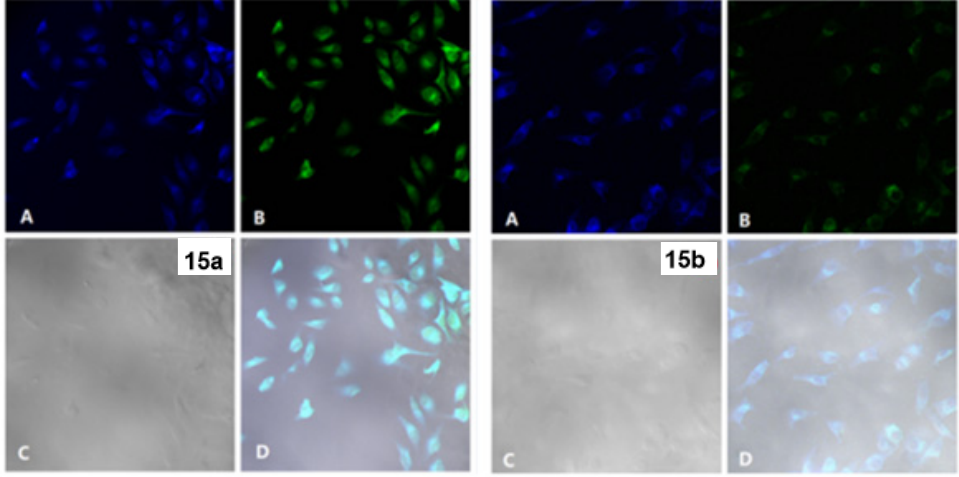
Figure 13. Confocal fluorescence images of HeLa cells stained with 15a and 15b . ( A ) DAPI channel fluorescence (405 nm), ( B ) FITC channel fluorescence (488 nm), ( C ) bright field image, and ( D ) merged images. Adapted from [41].